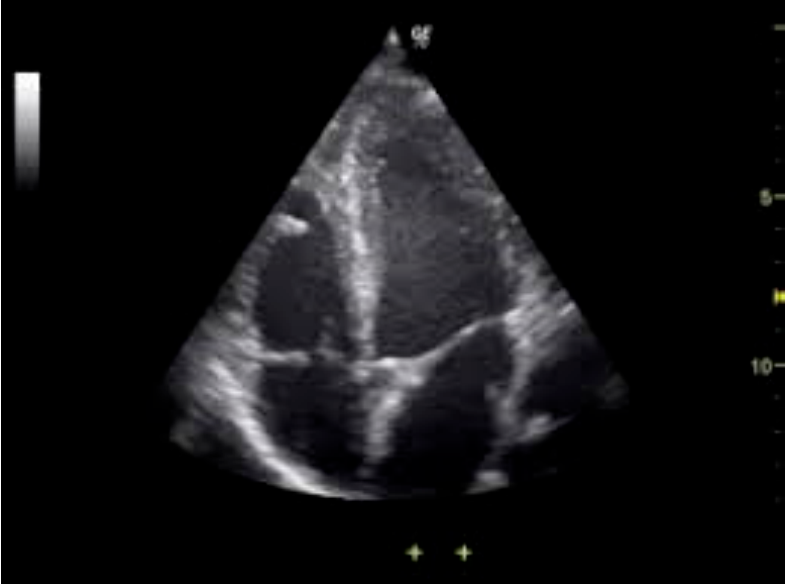
Figure 5. Postoperative echocardiography showed normal findings.